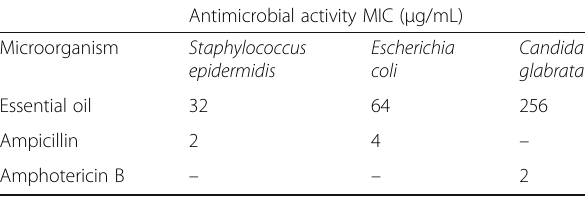
Table 3 Antimicrobial activity of aerial parts of M. spicata essential oil measured by MIC ( μ